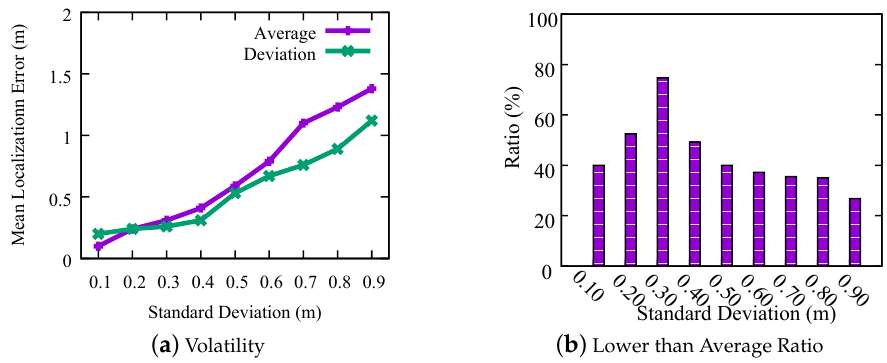
Figure 4. Further analysis on performance of MLE